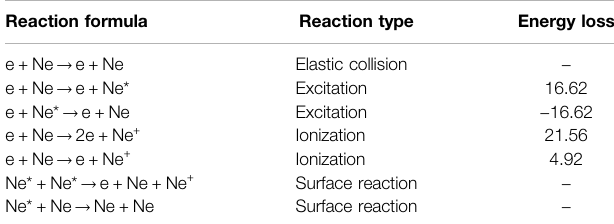
Frontiers in Physics |